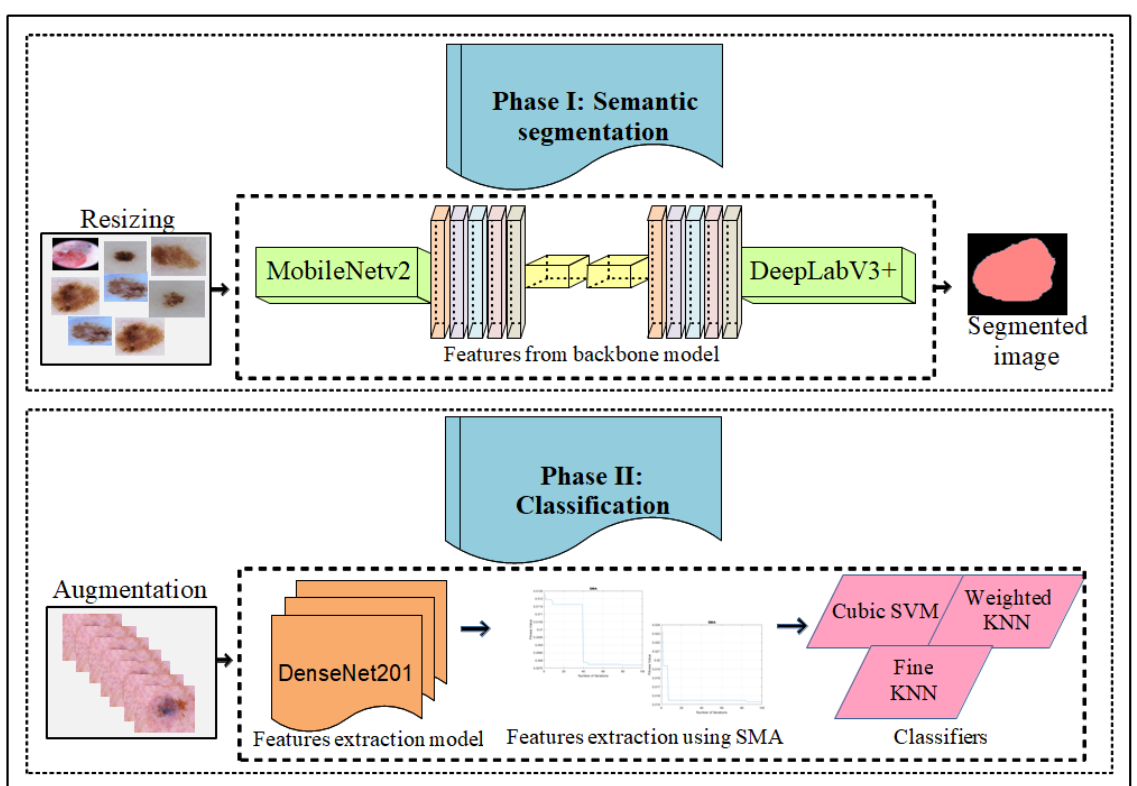
Figure 1. Skin lesions’ recognition. Segmentation using Mobilenetv2 and DeepLabv3+; classification based on DenseNet-201 and SMA with SVM, KNN classifiers.